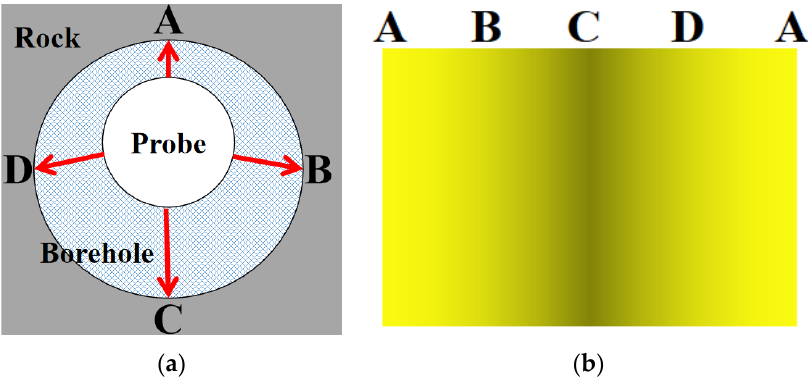
Figure 2. Schematic representation of the light intensity at eccentric position: ( a ) schematic diagram of position relationship and ( b ) schematic diagram of expanding the light intensity.